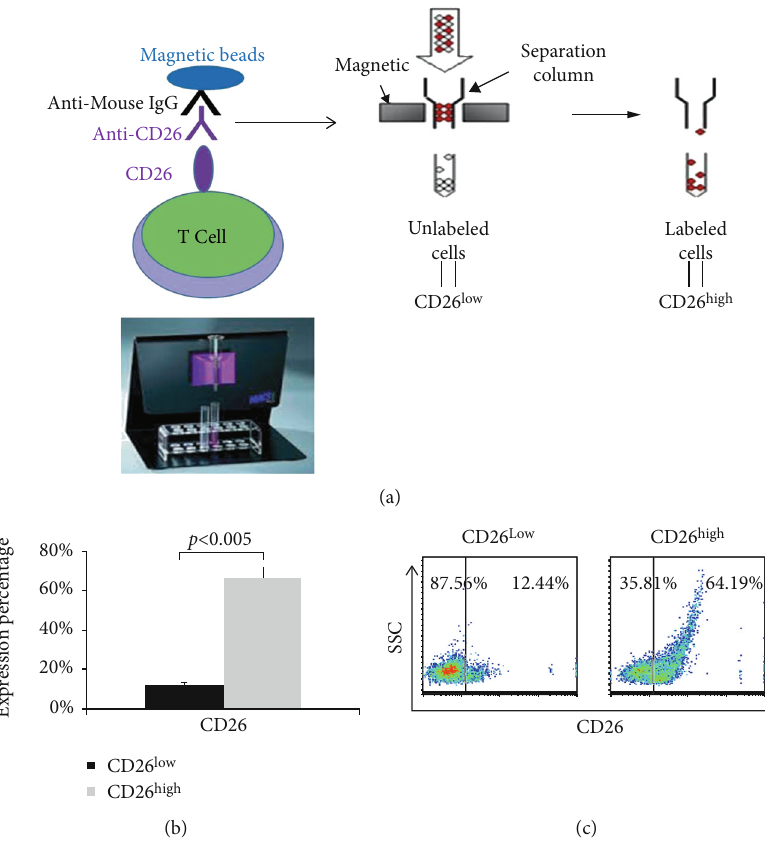
Figure 3: Separation of CD26 low and CD26 high lymphocytes by magnetic cell sorting (MACS). (a) Procedure of separation of CD26 low and CD26 high lymphocytes by MACS. After stimulation for three days, lymphocytes were labeled with the mouse anti-human CD26 mAb (anti-CD26 mAb prepared in our own laboratory) for 1 h at 4 ° C. Following the two washing steps, magnetic MicroBeads labeled with 350 anti-mouse IgGwereaddedtothecellsandincubatedfurtherfor15 minat4 ° C.Afterawashingstep,cellswereloadedintothecolumnwhichwas preplaced in the magnetic fi eld of a suitable MACS Separator (Miltenyi Biotec, Germany). The unlabeled cells were collected after fl ow-through with two times wash processes. The labeled CD26 + cells were bound to the column and then fl ushed out after removing the column from the separator by help of a plunger. (b) Analysis of CD26 expression in the CD26 high-expressing (CD26 high ) group and the CD26 low-expressing (CD26 low ) group by fl ow cytometry. Data represented mean value ± SD from a minimum of fi ve independent experiments with at least fi ve healthy donor HPBL samples. (c) The dot plots show one typical experiment for analysis of CD26